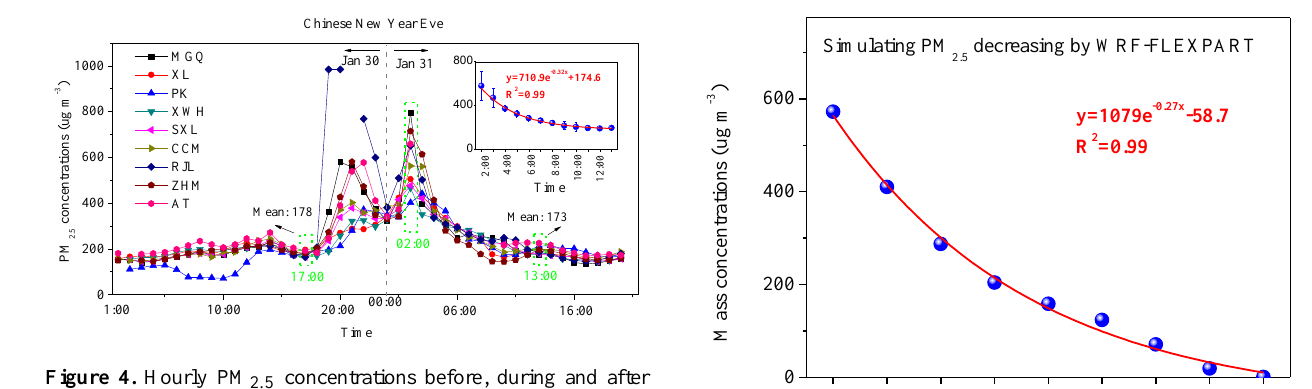
Figure 4. Hourly PM 2 . 5 concentrations before, during and after Chinese New Year (CNY)’s Eve of 2014 in Nanjing. The figure at the top-right corner indicates the decreasing trend of averaged PM 2 . 5 mass concentrations after 02:00 of CNY’s Eve (on 30 Jan- uary, 2014). Hourly data for the nine sites in urban Nanjing (loca- tions were shown in supplement Fig. S4) were collected from the public platform at http://218.94.78.75/jsair/.